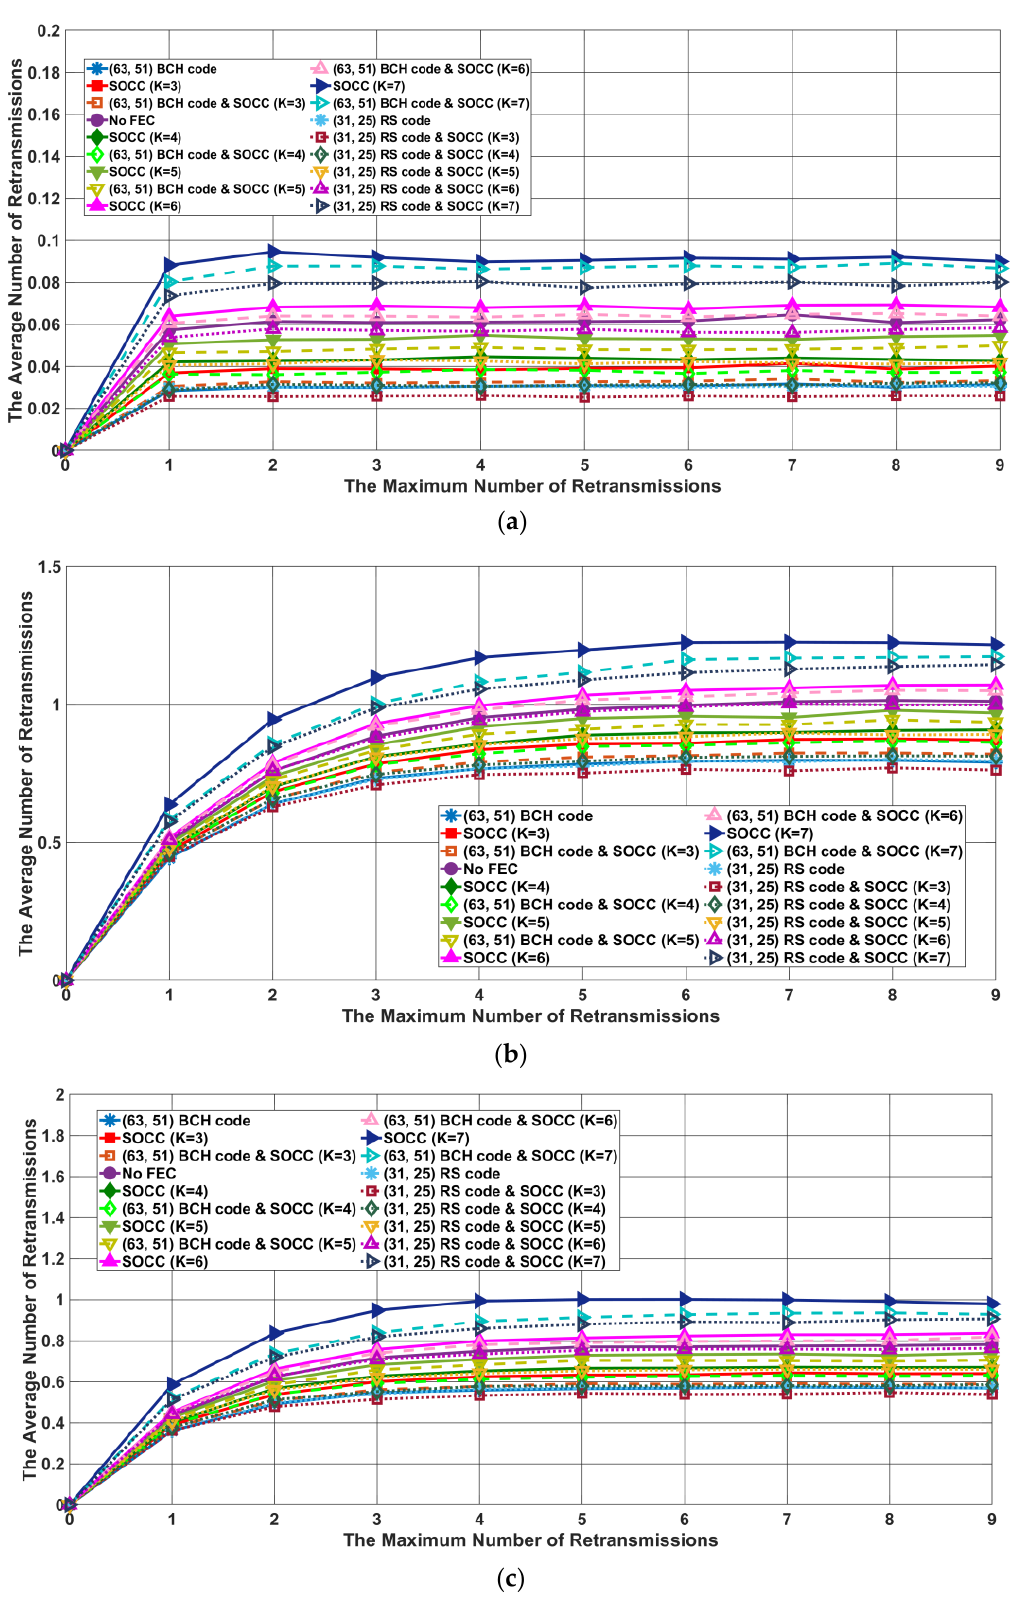
Figure 12. The average number of retransmissions as a function of the maximum number of retransmissions in the case of the burst pulse option with 𝑁 𝑐𝑝𝑏 𝑅 𝑆𝑂𝐶𝐶−1 = 32 for each link type: ( a ) LD, ( b ) MD, and ( c ) HD.